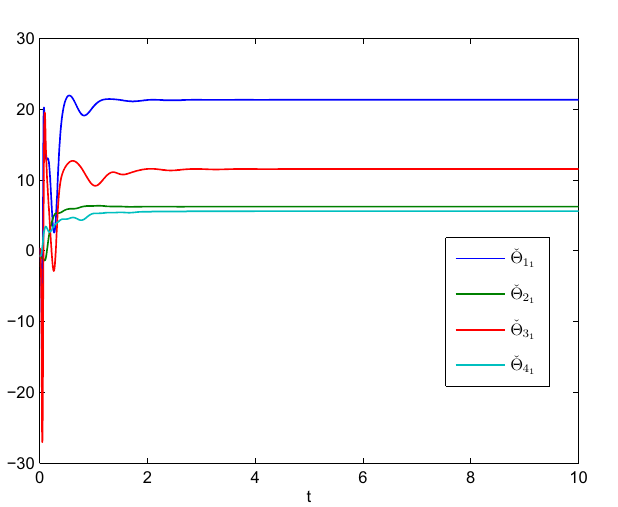
ˇ Θ i 1 ( i = 1, 2, 3, 4 ) of all two-link manipulators corresponding to